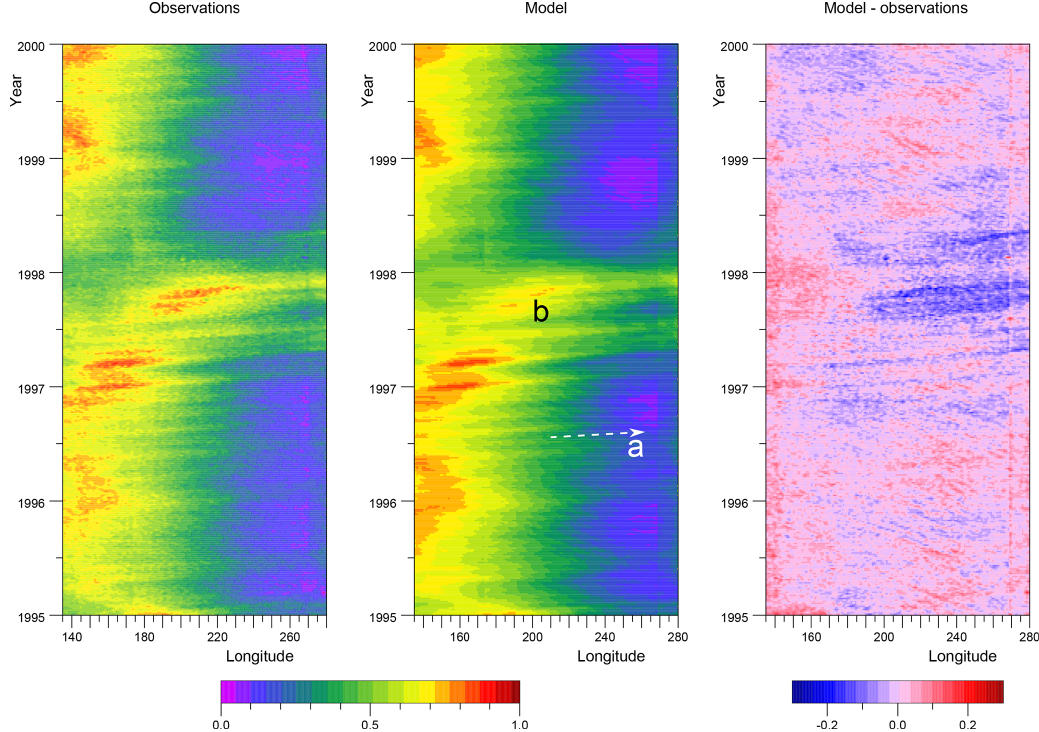
Figure 5. Observed and model sea surface height and their difference in the Pacific on the Equator between 135 and 280 ◦ E (80 ◦ W), showing (a) eastward-propagating Kelvin waves and (b) sea level high moving to the central Pacific. Units are